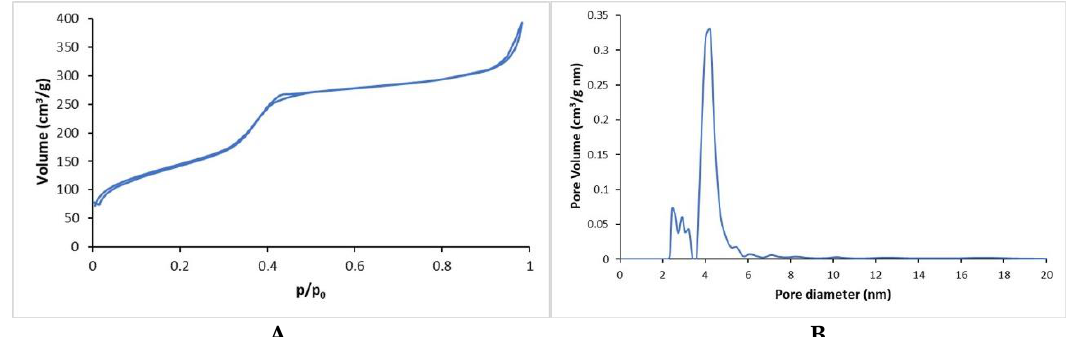
Figure 1. N 2 adsorption–desorption curves of MBG_Sr4%: ( A ) isotherms and ( B ) density functional theory (DFT) pore size distributions.